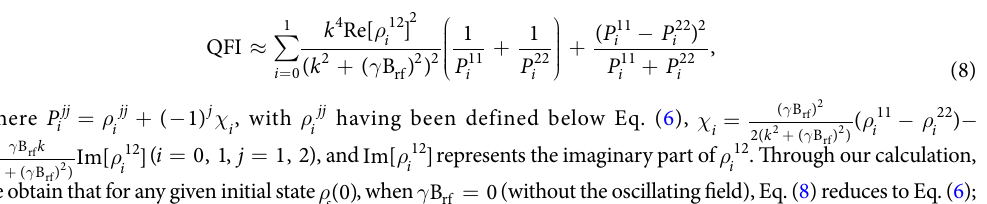
Figure 1. The QFI as a function of the direction angle θ without the oscillating field ( µ = B 46 line), µ = . B 59 8 T (black dashed line), and µ = . B 32 2 0 =